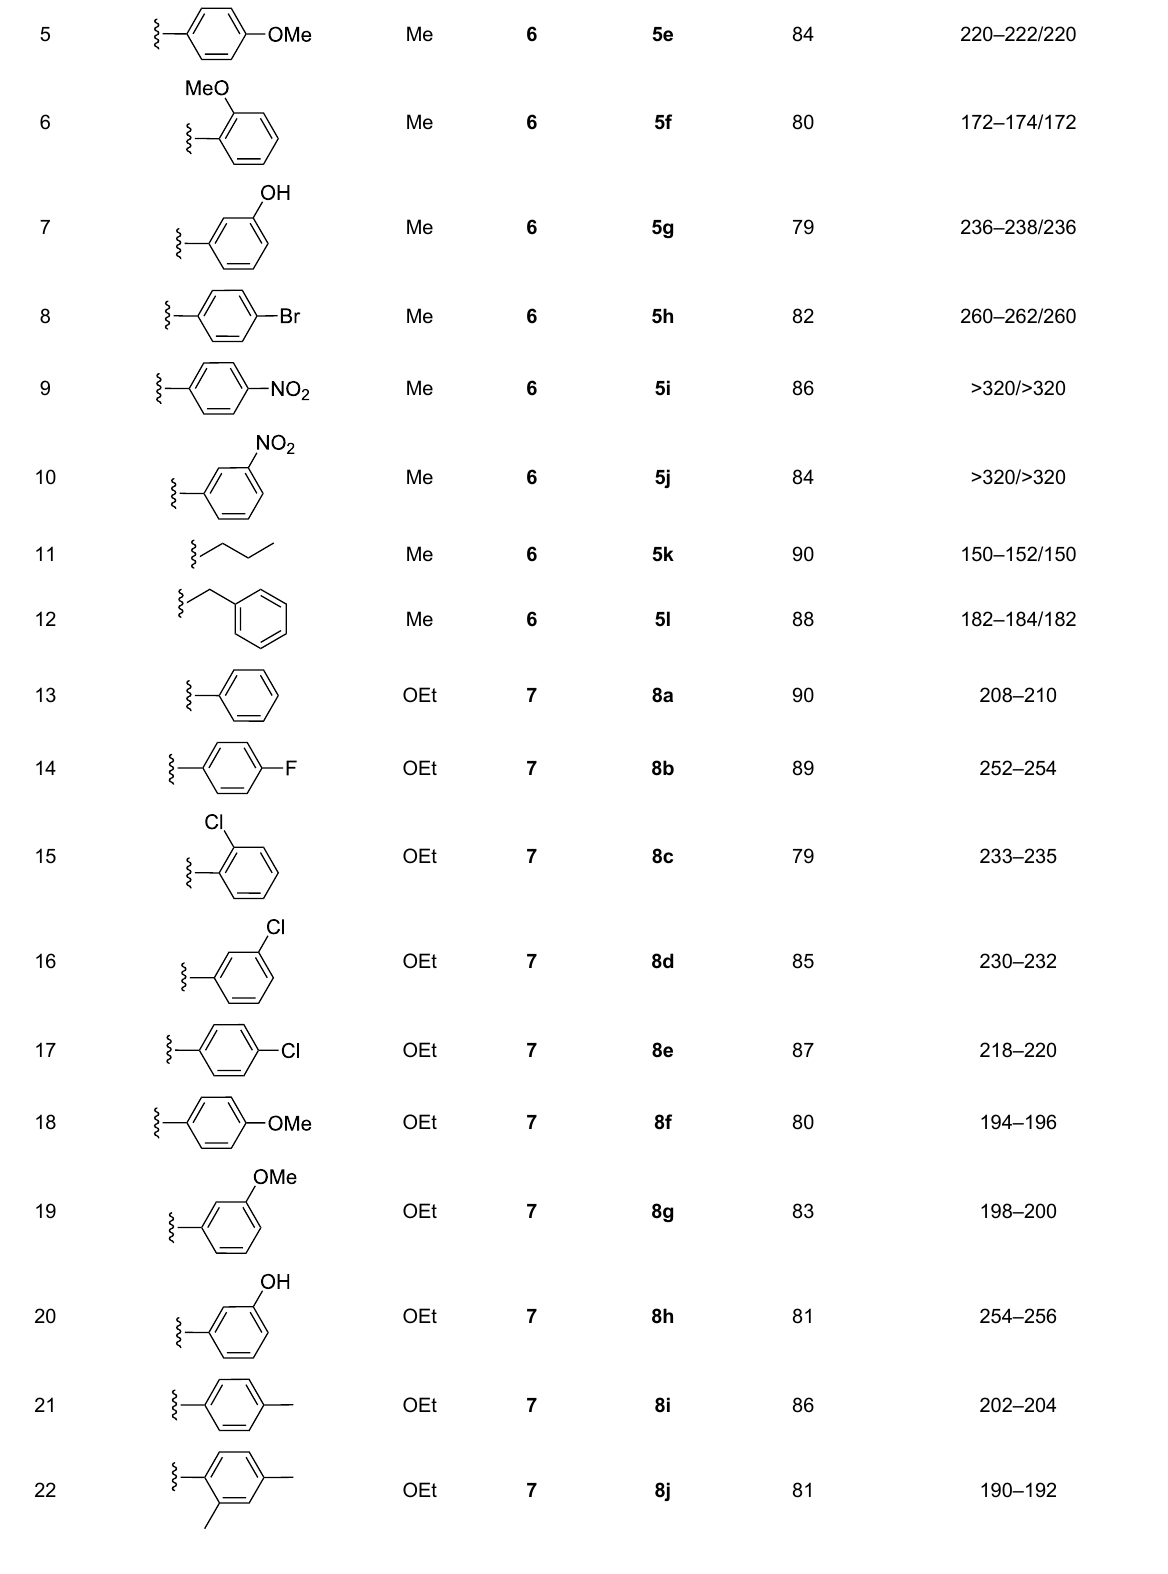
Table 2: Formation of isocoumarins 5 and 8 from adducts 6 and 7 respectively on an SSA surface.